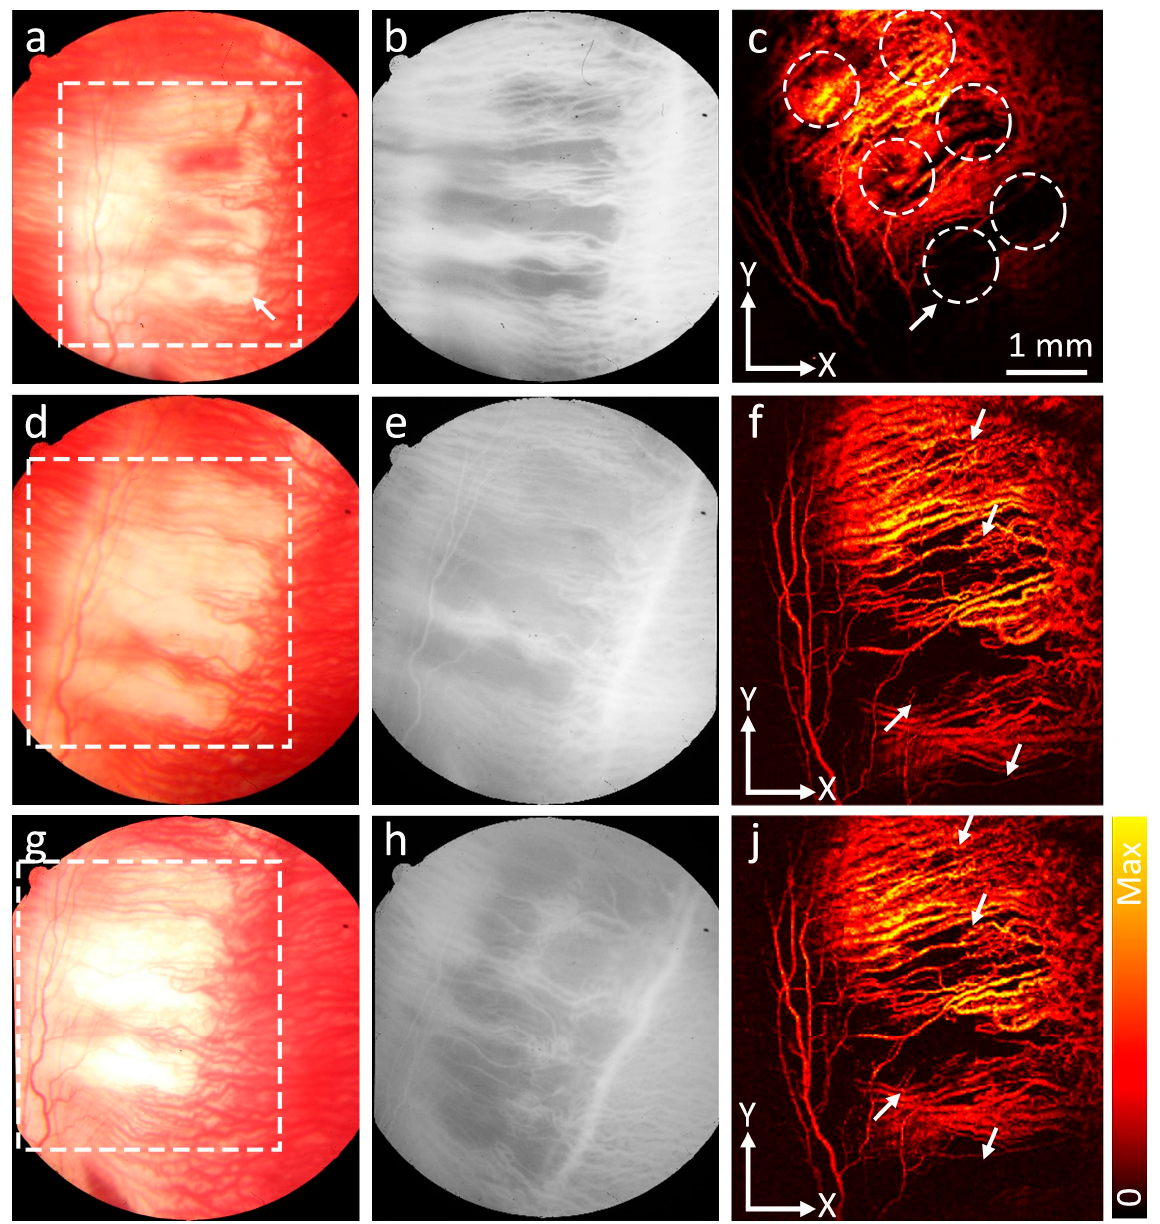
Figure 5. In vivo PAM images of CVO model. Position of CVO was clearly detected on the PAM images obtained at 578 nm. The treated area significantly changed over time. ( a , d , g ) Color fundus photographs of CVO at day 0, 7,and 28, respectively. ( b , e , h ) Fluorescein angiography (FA) images of CVO at day 0, 7,and 28, respectively. ( c , f , j ) Corresponding PAM images obtained at 578 nm along the selected area (white dotted rectangular) shown in a,d, and g at day 0, 7,and 28, respectively. White arrows demonstrate the location of laser injury sites.